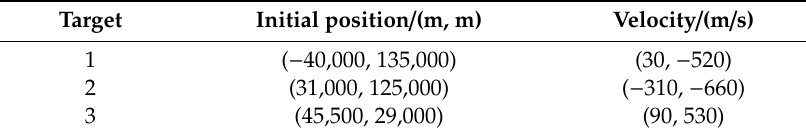
Table 4. State parameter of targets.